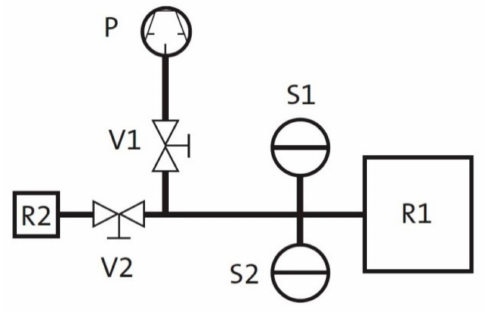
Figure 2. Set-up for leakage rate